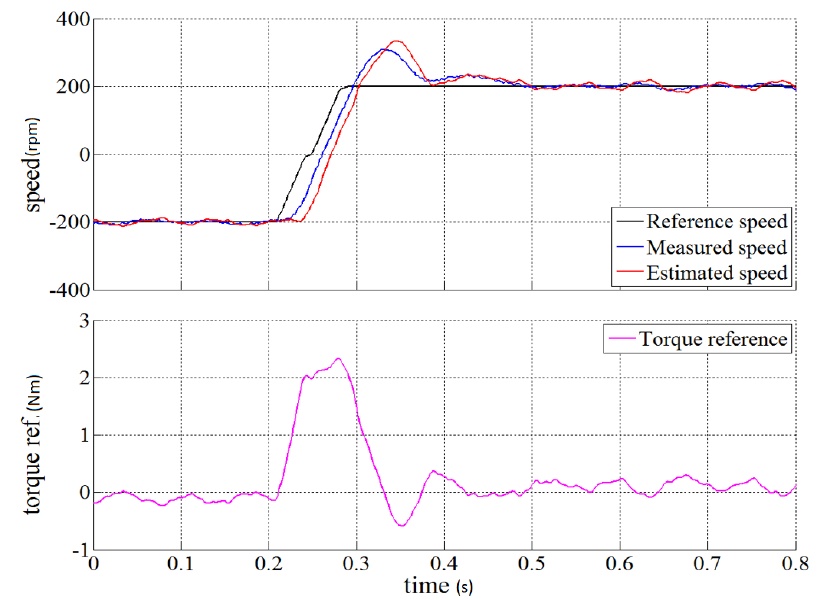
Figure 11. Motor #1: Sensorless speed control (MTPA), – 200 to +200 rpm inversion, proposed (self-adaptation) rotating voltage injection, no load.